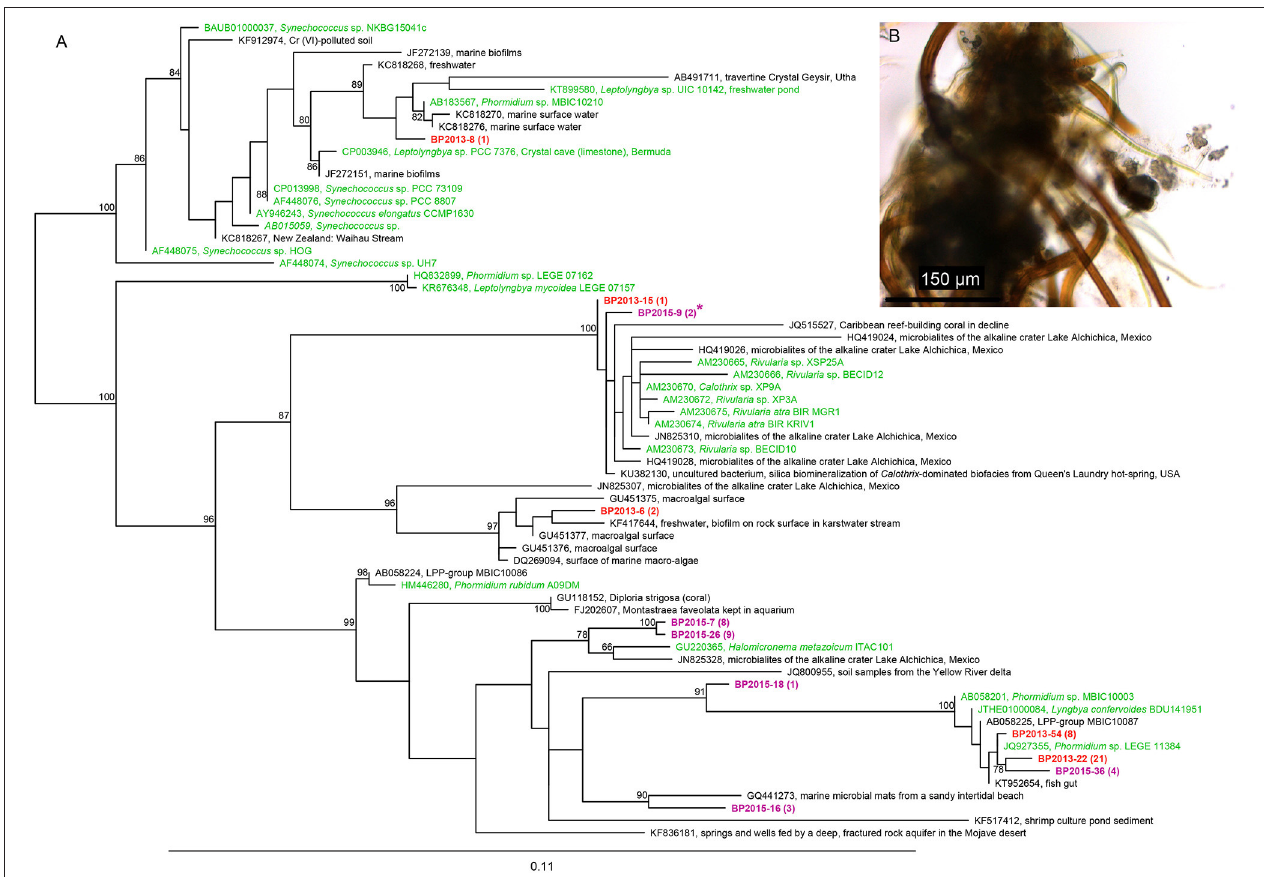
FIGURE 4 | (A) Phylogenic tree of the 16S rRNA encoding gene sequences of cyanobacteria retrieved using the cyanobacterial specific primers in the black pustular mats in 2013 (red) or 2015 (purple). Numbers in parentheses represent the number of clones obtained for each operational taxonomic unit (OTU) defined at a sequence similarity ≥ 97%. The cyanobacteria sequence identified in the consortium isolated by laser microdissection corresponds to BP2015-9*. The tree was constructed with the ARB software (Ludwig et al., 2004) by Maximum Likelihood analysis using 1,097 positions, by including the closest possible uncultivated (black) and cultivated (green) relatives as well as more distant representatives of cultivated species. Bootstrap values for nodes ( > 70% support) based on 1,000 replicates are displayed as percentages. (B) Optical microscopy image of one of the consortia isolated by laser microdissection and showing Rivularia